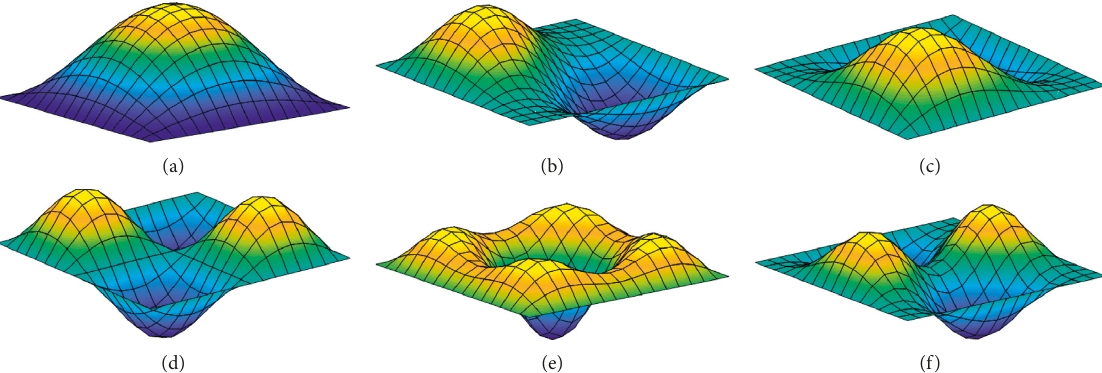
Figure 16: The first six mode shapes of a two-layer square SSSS composite plate. (a) Mode 1. (b) Mode 2. (c) Mode 3. (d) Mode 4. (e) Mode 5. (f) Mode 6.